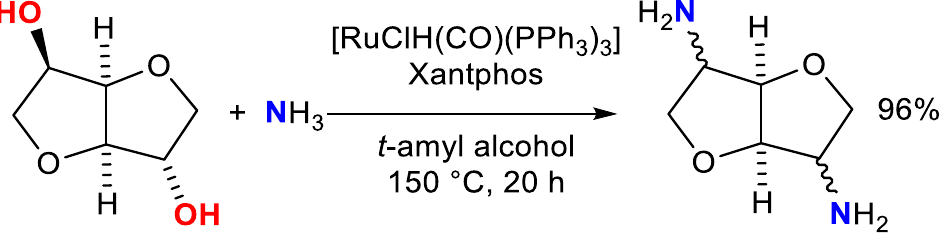
Table 6. Catalytic isohexides diamination using ammonia as a nitrogen